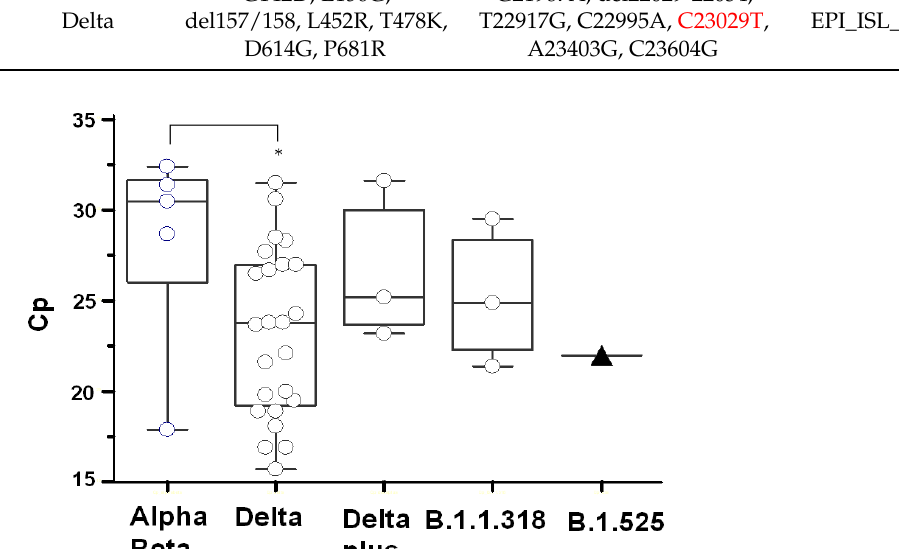
Figure 2. Viral loads for the SARS-CoV-2 variants. The viral RNA in each nasopharyngeal specimen is quantified by the crossing point (Cp) on the RT-PCR amplification curve. The median, 95% CI, and range of Cp values for the SARS-CoV-2 variants and B.1.1.318 PANGO lineage are represented by box-whisker plots. The single Cp value of the eta variant belonging to the B.1.525 PANGO lineage is represented by a filled